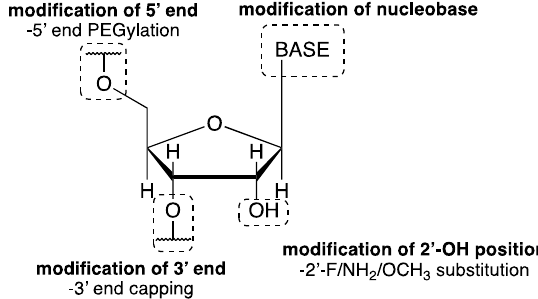
Figure 9. Common strategies in chemical modifications of RNA aptamers (adapted from ref. [217] ).